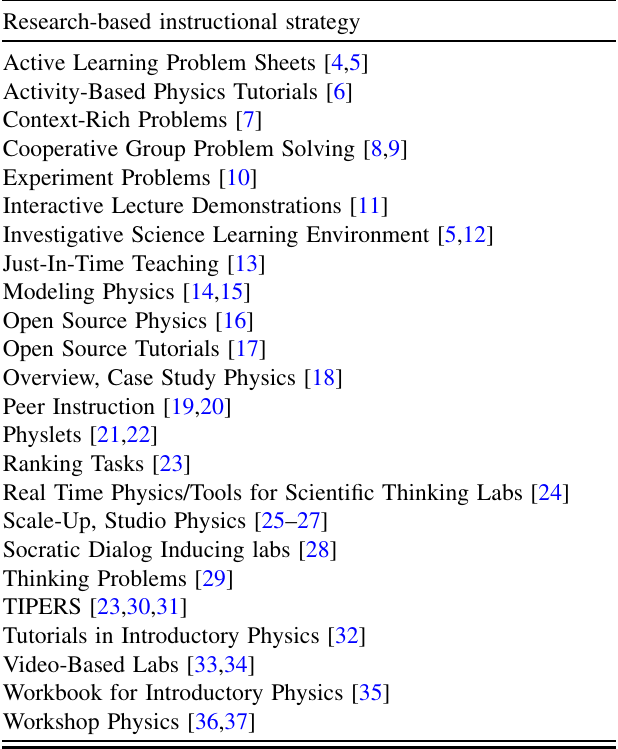
TABLE I. Twenty-four research-based instructional strategies included in the Web